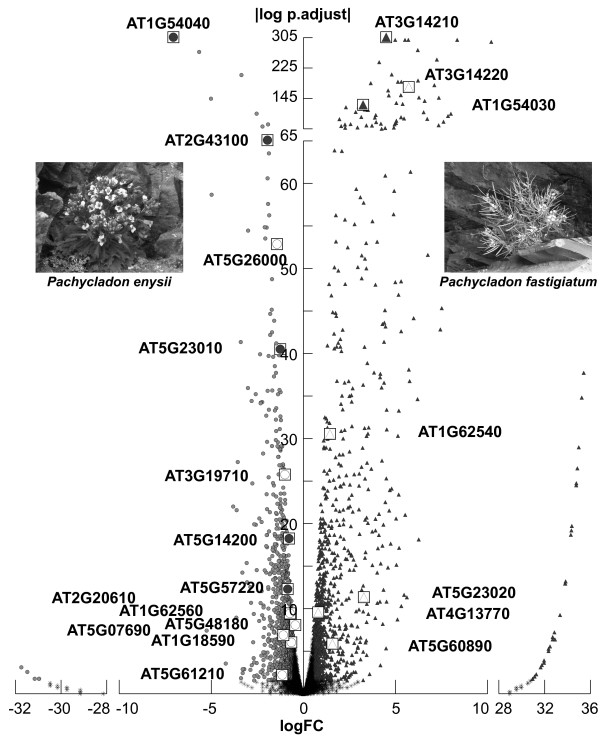
Volcano plot depicting DEGs obtained using P. fastigiatum full-lengths ESTs as a reference for tag mapping (P0). 1,239 and 1,039 genes were determined as differentially expressed in P. enysii (circles) and P. fastigiatum (triangles), respectively. Log fold ratios >28 and < −28 indicate genes with zero tags in either of both species whereas log fold ratios between −10 and 10 indicates genes with tags present in both species but differing in abundance. Five glucosinolate metabolism loci show similar up-regulation as in a previous microarray analysis [12] in P. enysii (AT1G54040, AT2G43100, AT5G23010, AT5G14200, AT5G57220; filled circles) as well as two loci in P. fastigiatum (AT3G14210, AT1G54030; filled triangles). Thus conclusions drawn from microarray analyses regarding glucosinolate phenotypes (AT1G54040 - ESP up-regulation indicates that P. enysii produces nitriles; AT3G14210 - ESM1 up-regulation indicates that P. fastigiatum produces isothiocyanates; AT5G23010, AT2G43100, AT5G14200 - up-regulation of methylthioalkylmalate synthase 1, methylthioalkylmalate isomerase, methylthioalkylmalate dehydrogenase indicates that P. enysii produces C4 glucosinolates) can be equally drawn from this tag profiling study. Eight additional loci involved in glucosinolate metabolism could be identified for P. enysii (AT5G26000, AT3G19710, AT2G20610, AT1G62560, AT5G48180, AT1G18590, AT5G07690, AT5G61210; empty circles) and five for P. fastigiatum (AT3G14220, AT1G62540, AT5G23020, AT4G13770, AT5G60890; empty triangles).